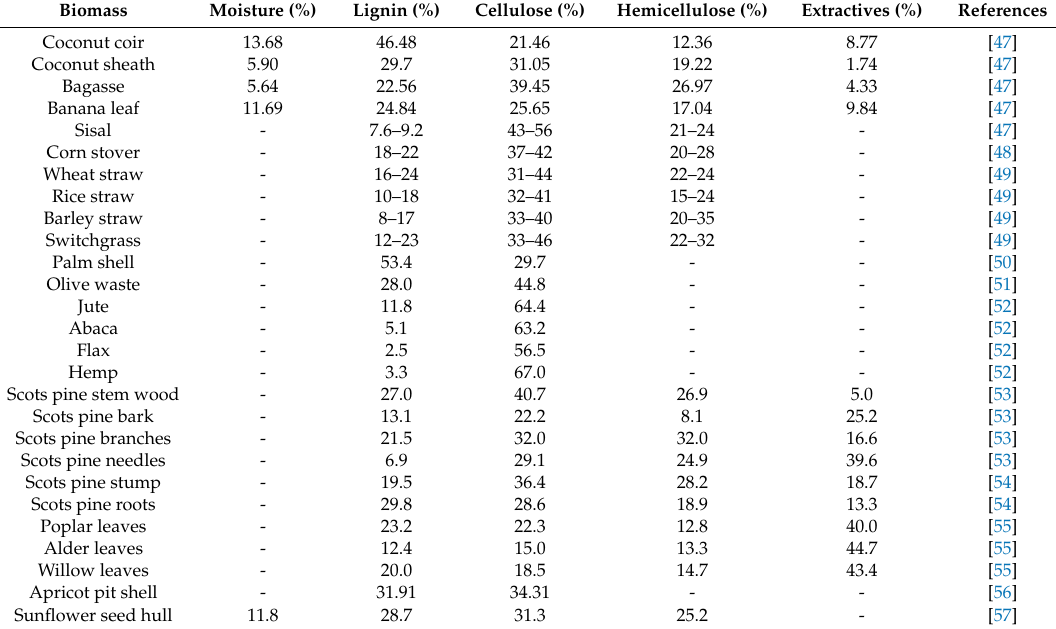
Table 1. Chemical compositions of different plant-based biomass (in dry weight % basis).